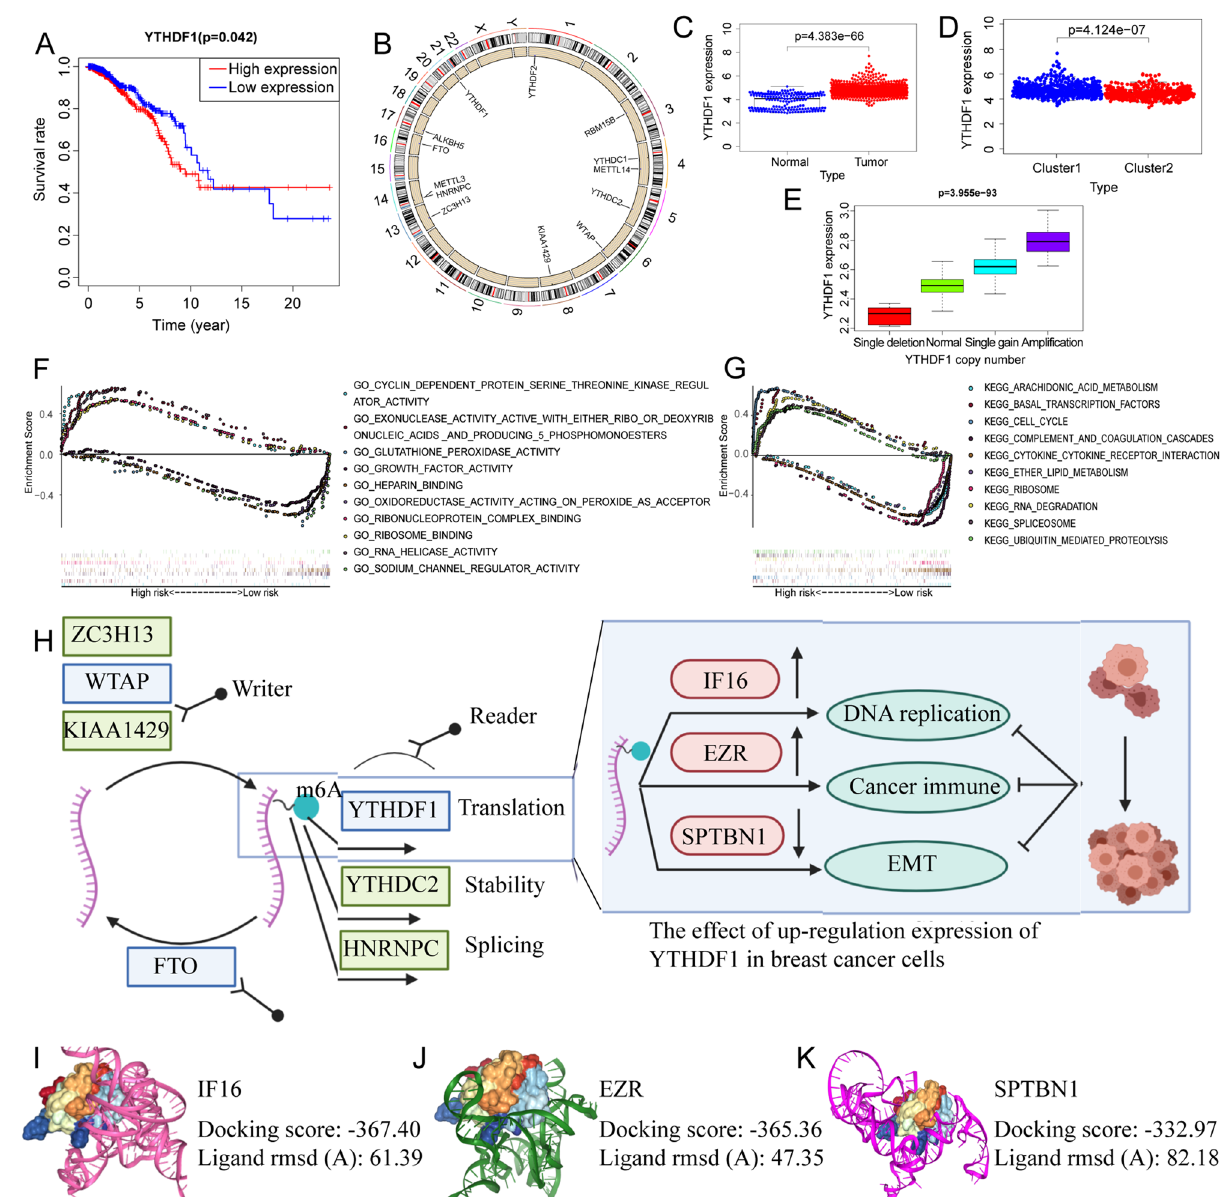
lost. ( C ) Difference analysis of YTHDF1 in breast cancer. The blue dots represent paracancer samples, and the red ones represent breast cancer samples. ( D ) The expression of YTHDF1 in the first two clusters. The blue dots represent low immune samples (cluster 1), and the red ones represent high immune samples (cluster 2) ( E ) Copy number variation analysis of YTHDF1. ( F , G ) GSEA enrichment analysis. ( F ) Gene ontology analysis. ( G ) Kyoto Encyclopedia of Genes and Genomes pathway enrichment analysis. ( H ) A schematic diagram of m6A regulators and the genes downstream of YTHDF1 in breast cancer. ( I – K ) The binding sites of YTHDF1 and its downstream targets were identified. The binding sites of circYap with PABP and eIF4G were predicted by NPDock. The docking quality of the model was confirmed. ( I ) YTHDF1 and IFI6 mRNA. ( J ) YTHDF1 and EZR mRNA. ( K ) YTHDF1 and SPTBN1